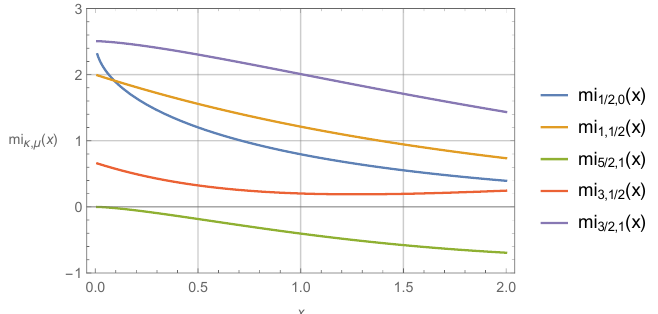
Figure 4. The integral Whittaker functions mi κ , µ ( x ) as a function of variable x at fixed values of parameters κ and µ .